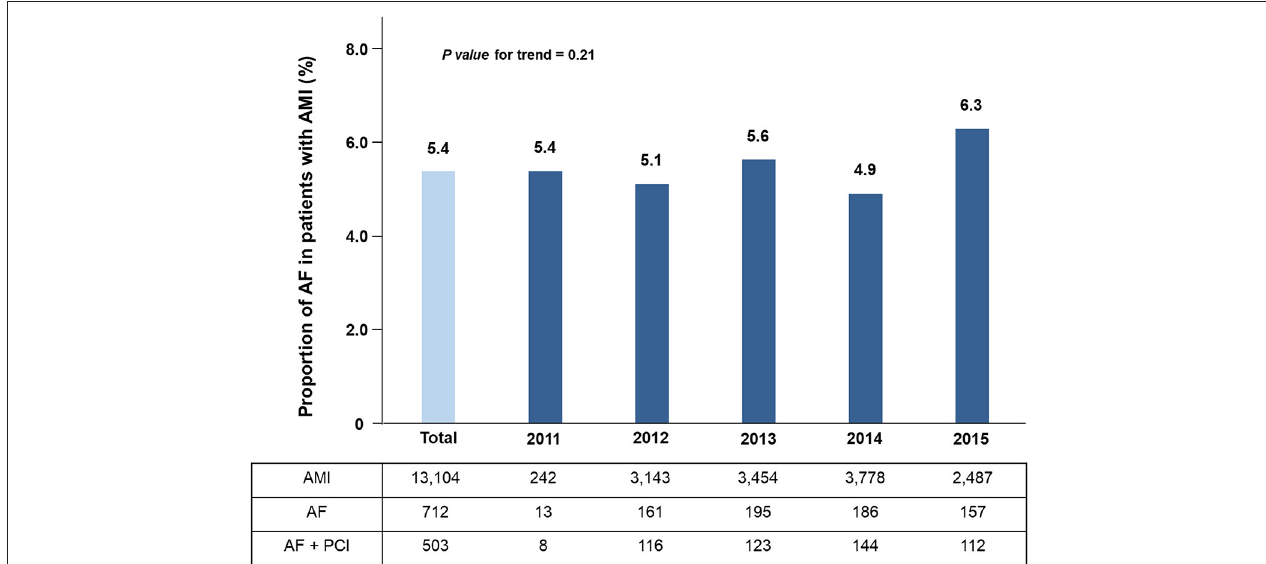
FIGURE 1 | The trend of annual AF incidence in patients with acute myocardial